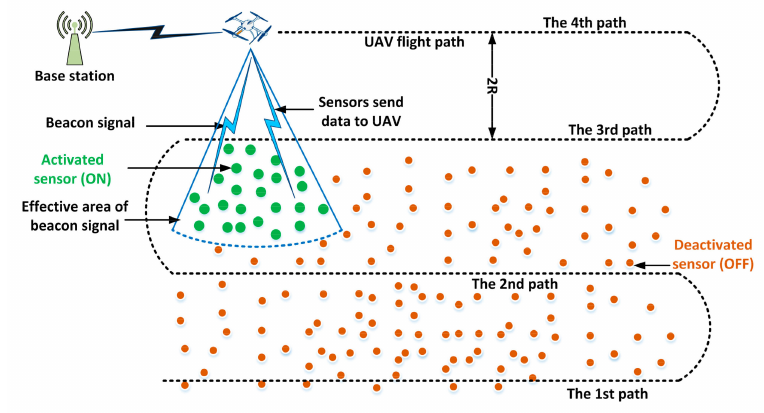
Figure 8. General architecture of a UAWSN